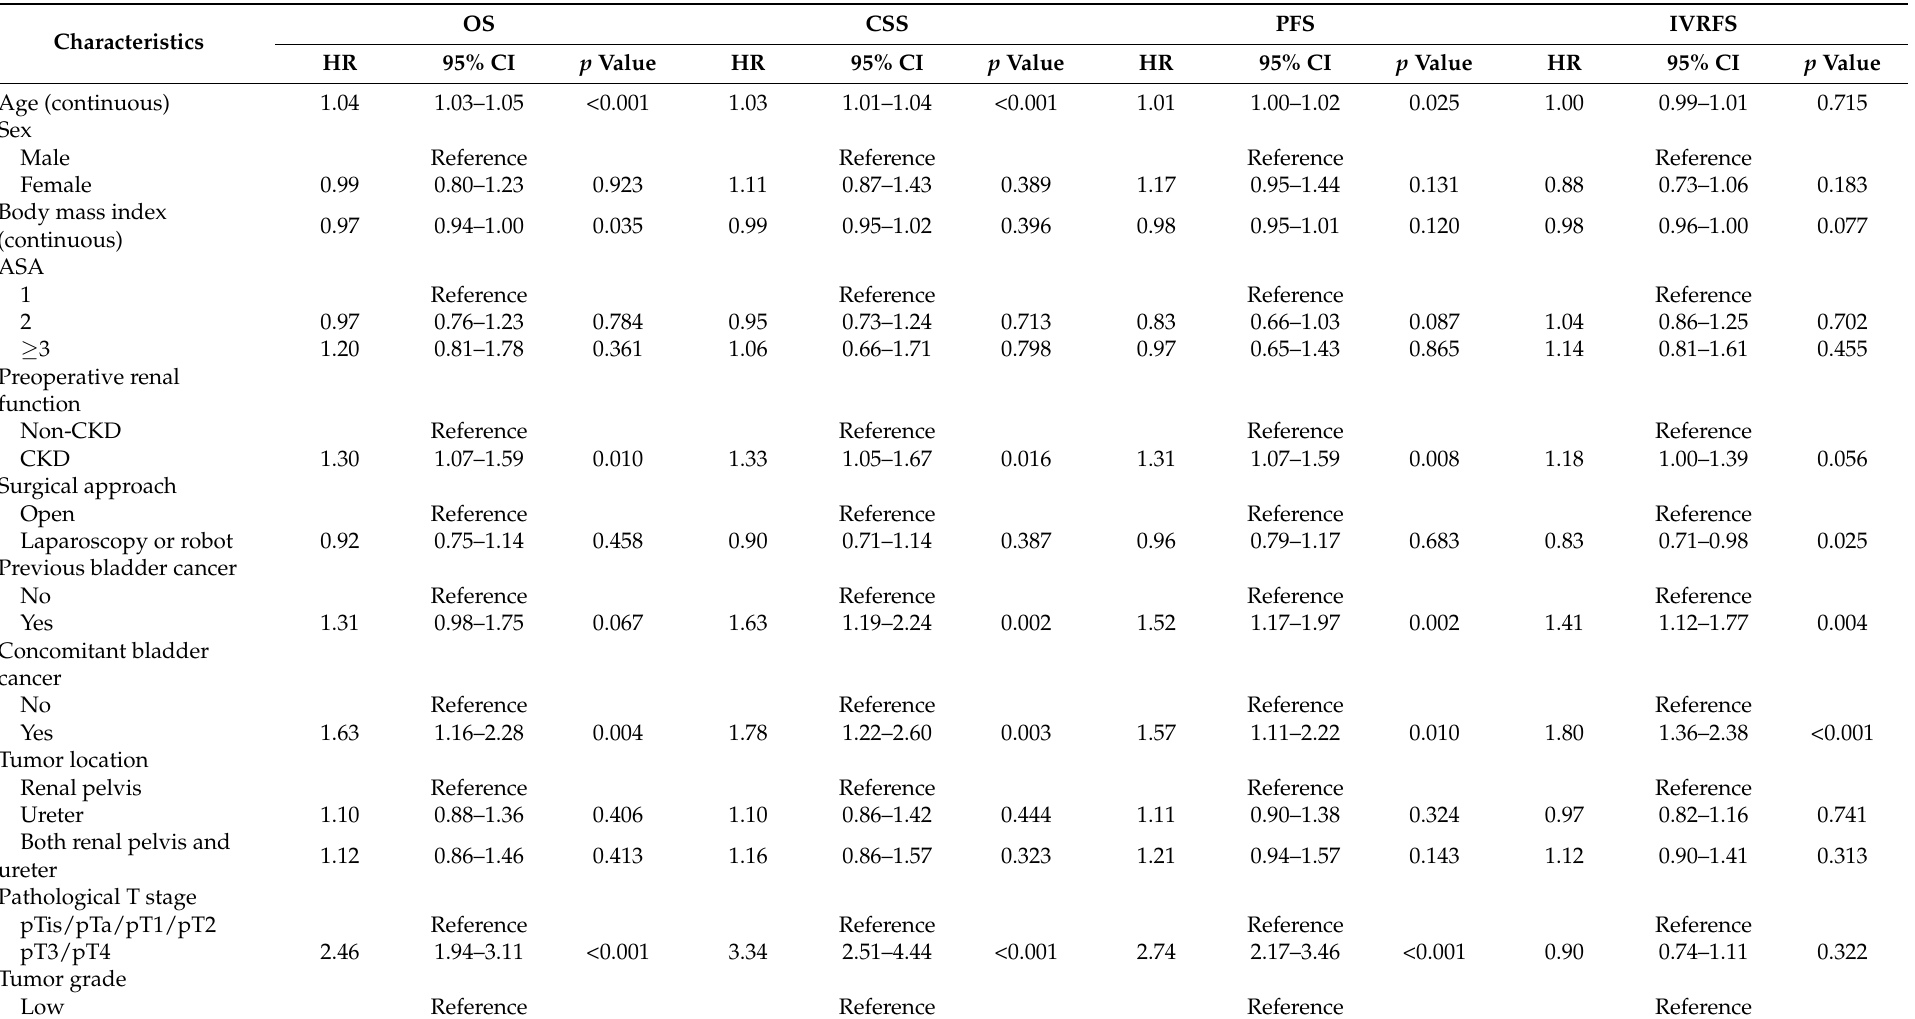
Table 2. Multivariable Cox proportional hazard regression analyses to predict death from all-cause, death from upper tract urothelial carcinoma, progression, and intravesical tumor recurrence in 1733 patients with upper tract urothelial carcinoma treated with radical